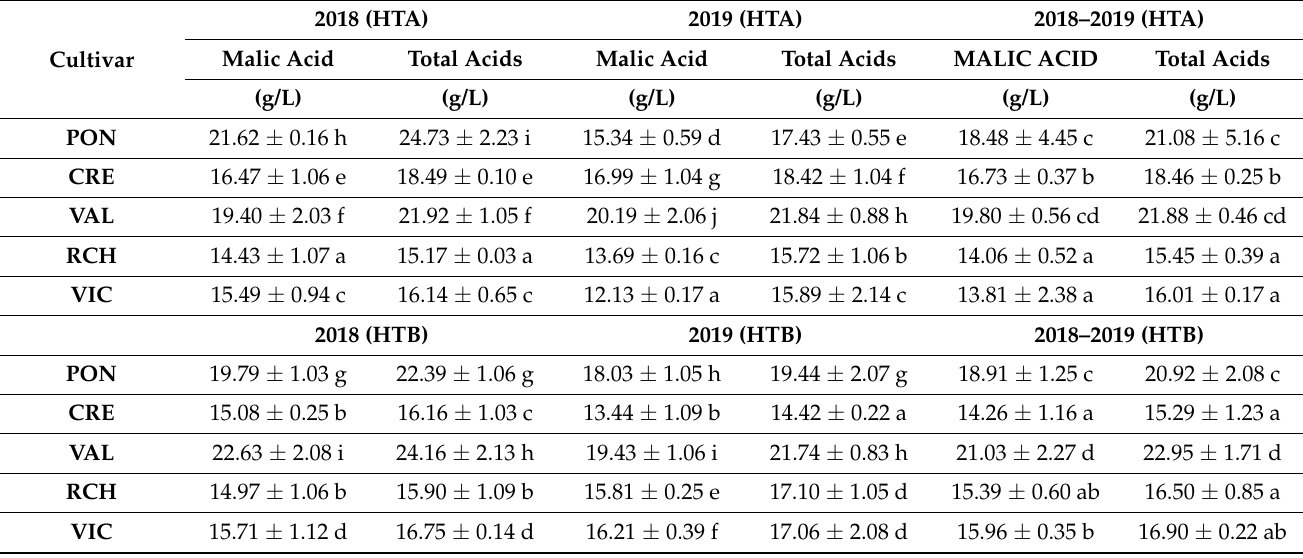
Table 9. Effect of cultivar on malic acid and total acid content in rhubarb juice.